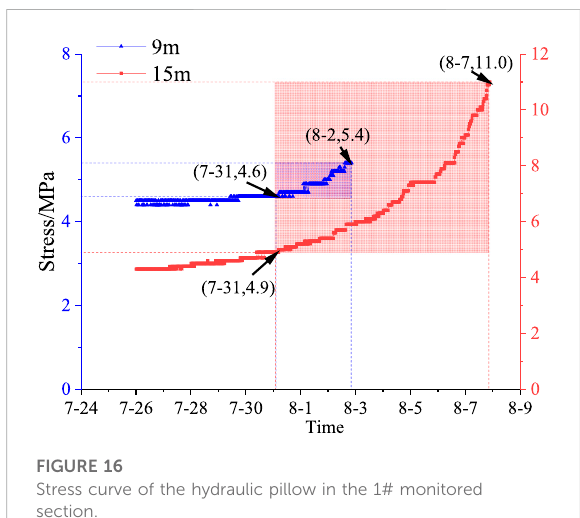
FIGURE 16 Stress curve of the hydraulic pillow in the 1# monitored